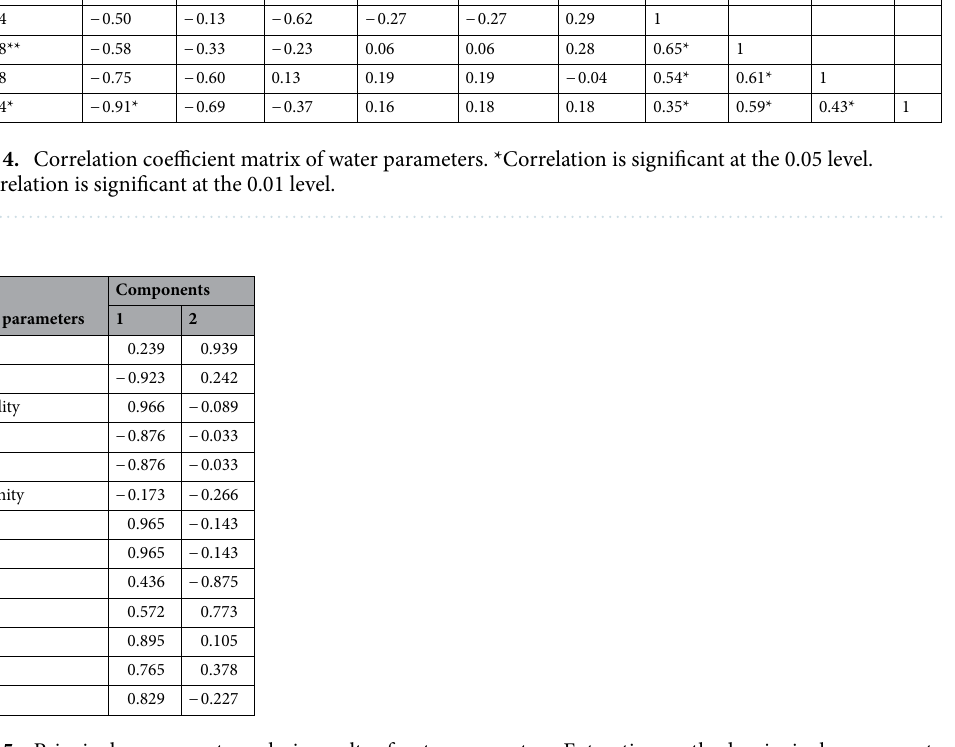
Table 5. Principal components analysis results of water parameters. Extraction method: principal component analysis and only 2 components